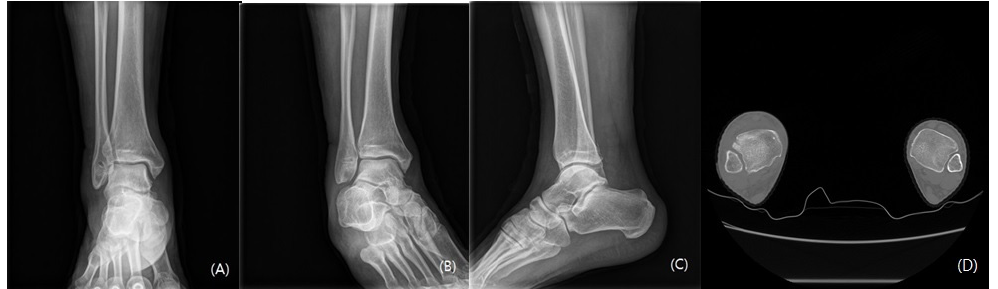
Figure 6. The syndesmosis joint was clearly reduced on the postoperative X-ray (( A ) anteroposterior view, ( B ) lateral view, and ( C ) mortise view); this was con fi rmed by axial computed tomography view, ( B ) lateral view, and ( C ) mortise view); this was confirmed by axial computed tomography ( D ( D ).